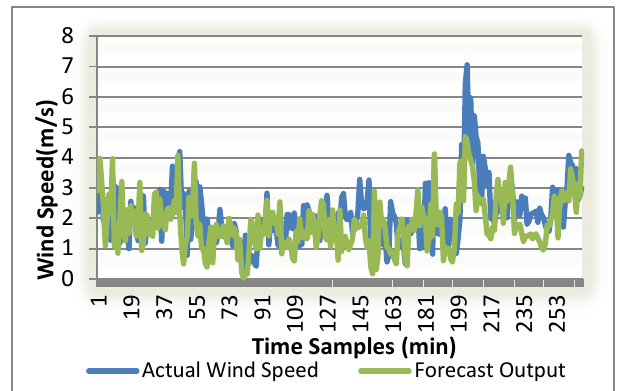
Figure 3. Actual and forecast wind speed output using BPN with feature selection